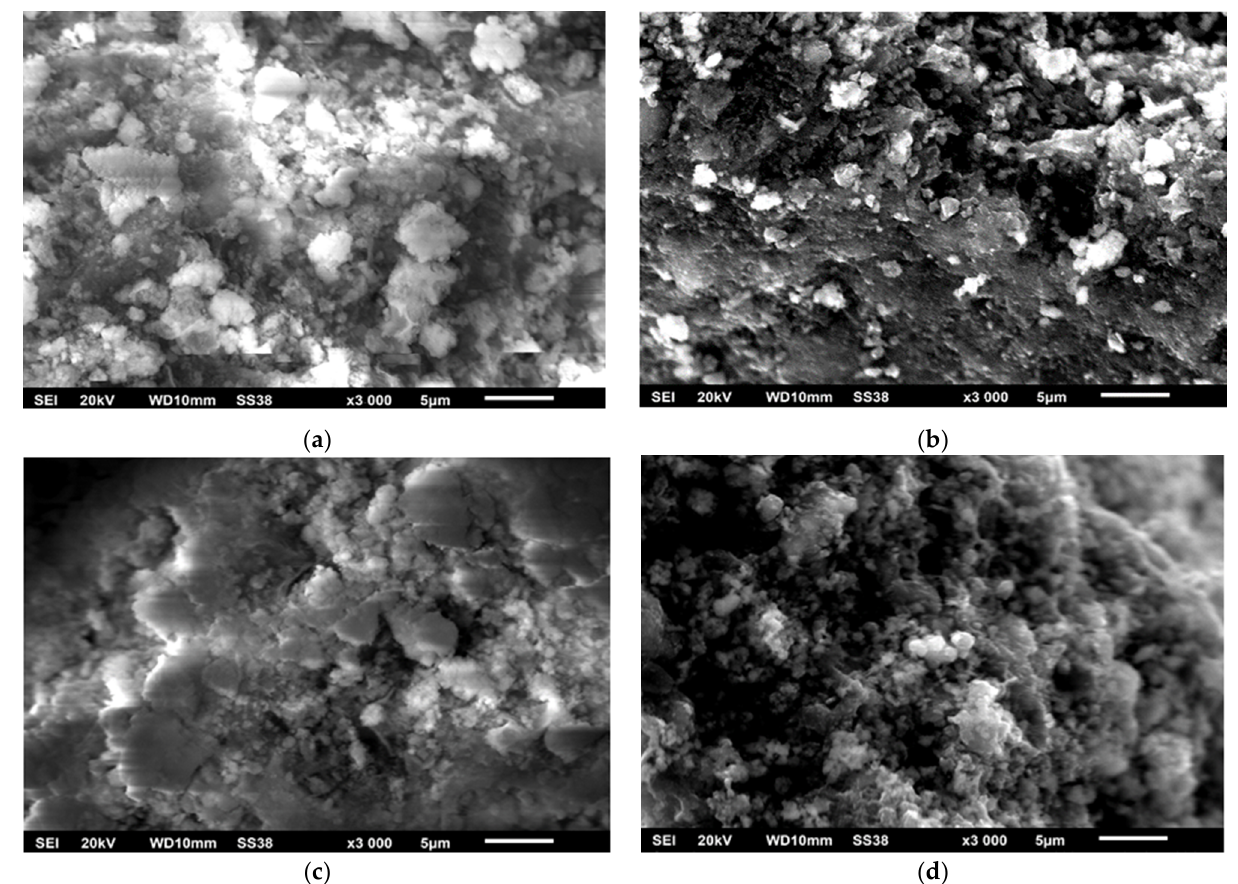
Figure 3. SEM patterns of ( a ) fresh and ( b ) used samples of 5%Co-Rh(95:5)/Al 2 O 3 catalyst and ( c ) fresh and ( d ) used samples of 5%Co-Rh(9:1)/Al 2 O 3 catalyst.